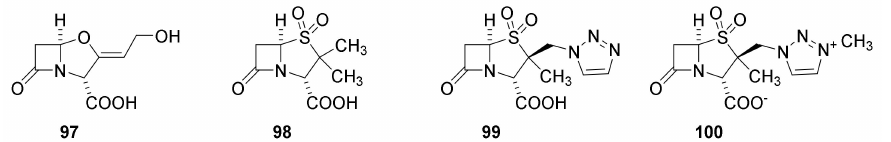
Figure 22. β -Lactamase inhibitors containing a β -lactam residue in the skeleton: clavulanic acid ( 97 ), sulbactam ( 98 ), tazobactam ( 99 ) and enmetazobactam ( 100 ) [119]. Sulbactam ( 98 ) is asumed to react irreversible with the β -lactamase as illustrated in Scheme 12